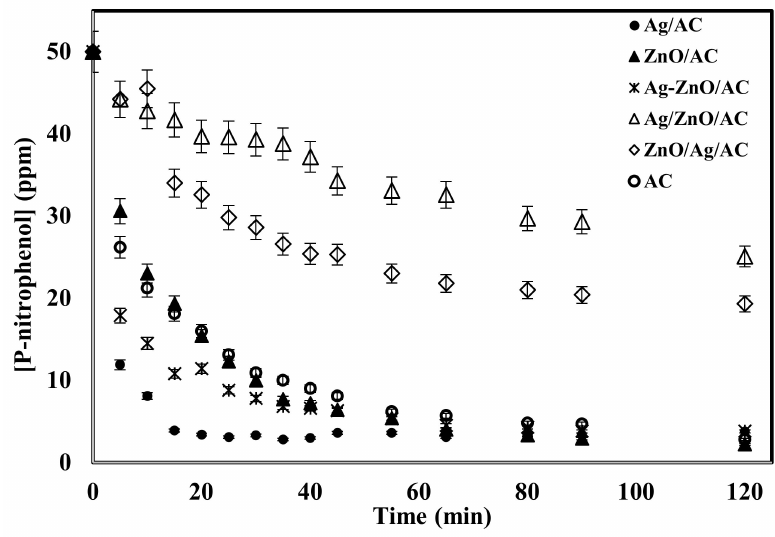
Figure 8. Decomposition of 4-nitrophenol using di ff erent catalysts under the conditions of 20 mL of 50